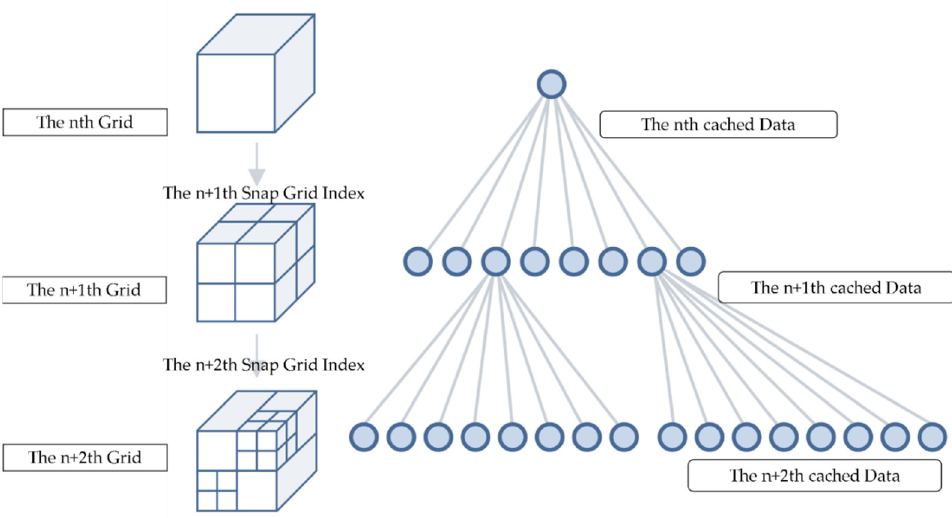
Figure 4. Adaptive octree Figure 4 . Adaptive octree model.